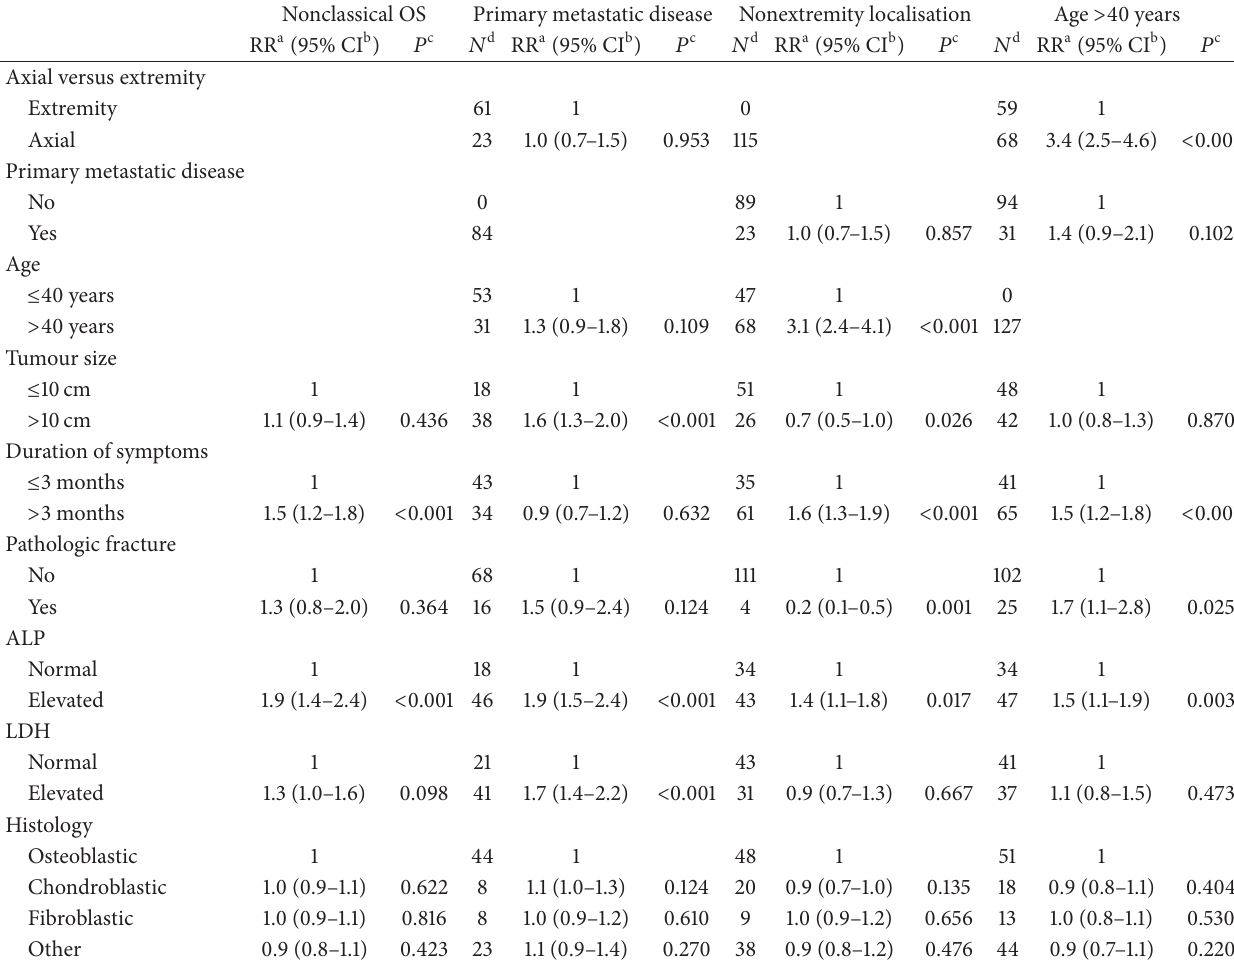
Table 2: Relative risk analysis among nonclassical osteosarcoma (OS) patients; primary metastatic disease, nonextremity localisation, and age > 40 years.